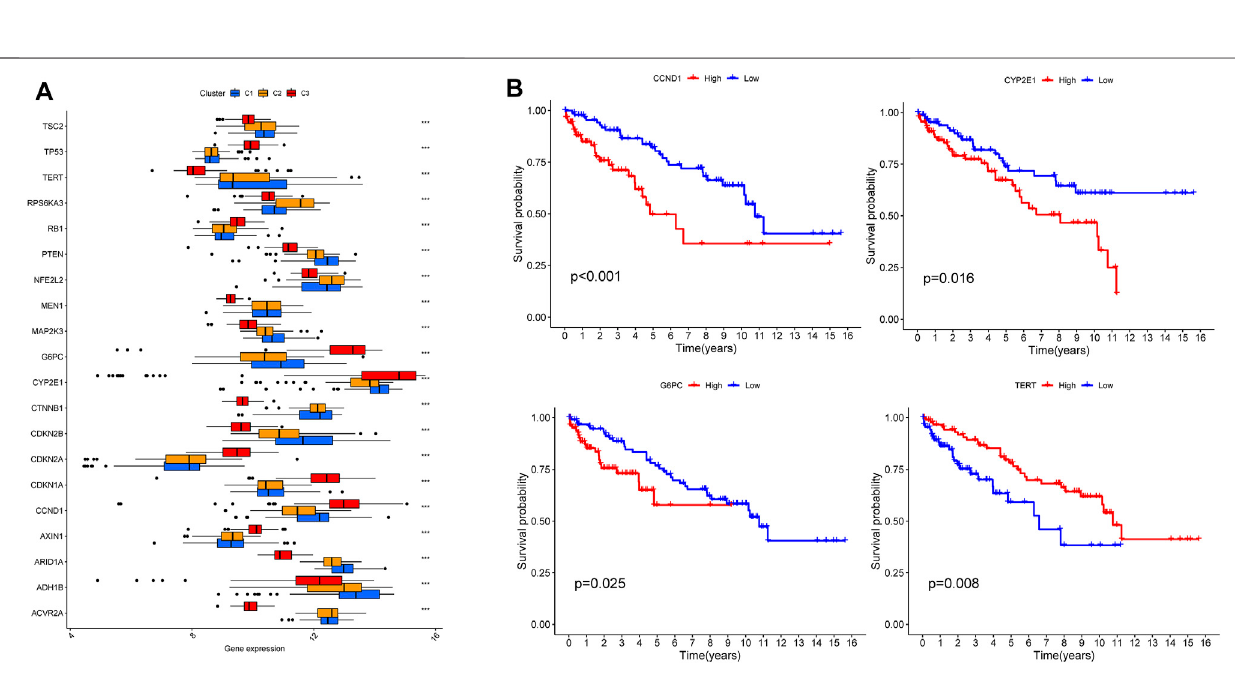
Frontiers in Genetics |